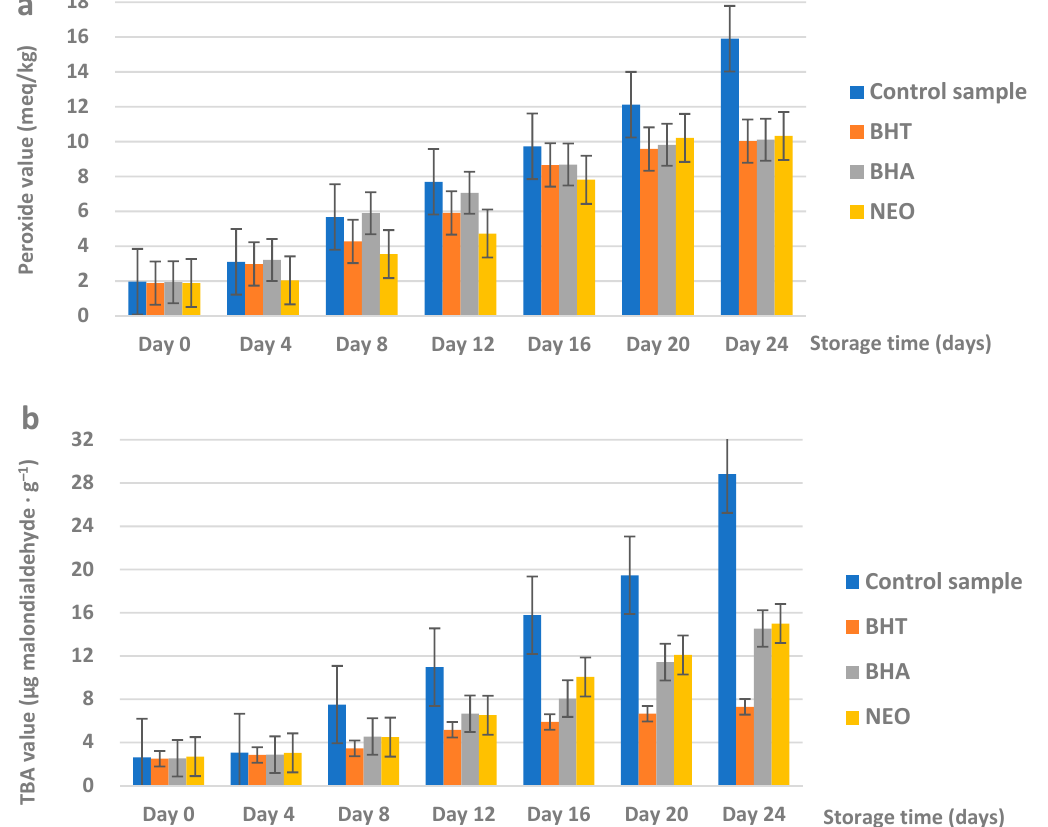
Figure 1. Antioxidant activity of samples treated with NEO, butylated hydroxyanisole (BHA), and butylated hydroxytoluene (BHT) in terms of peroxide values (PVs) ( a ) and thiobarbituric acid (TBA) values ( b ) of cold-pressed sunflowers oil during 24 days of the storage period.